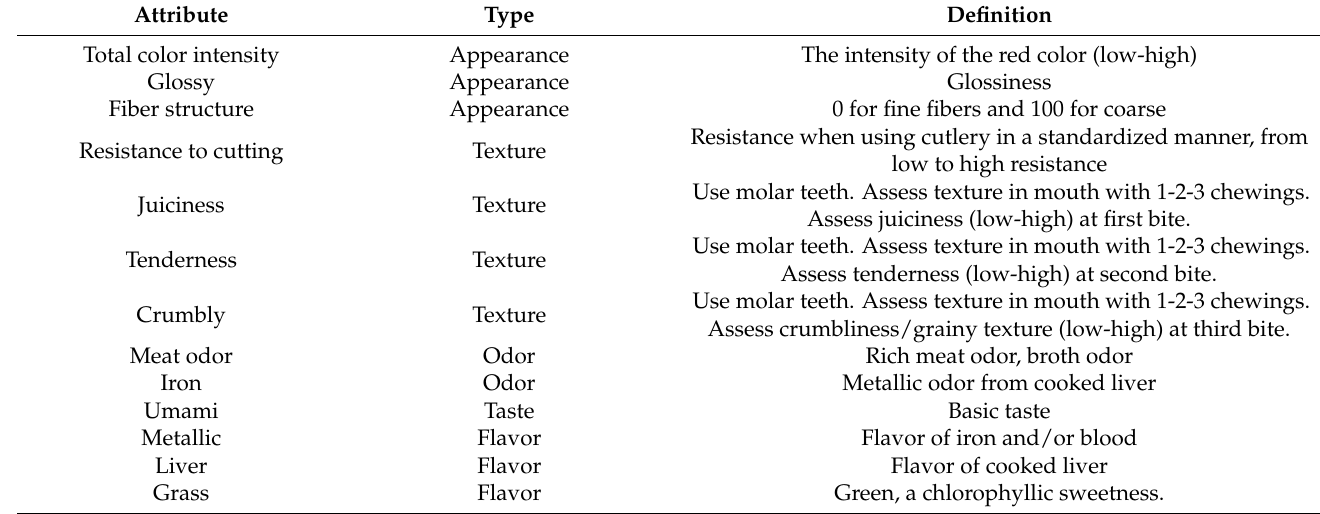
Table 1. Sensory attributes and definitions used in the sensory analysis of the four goose